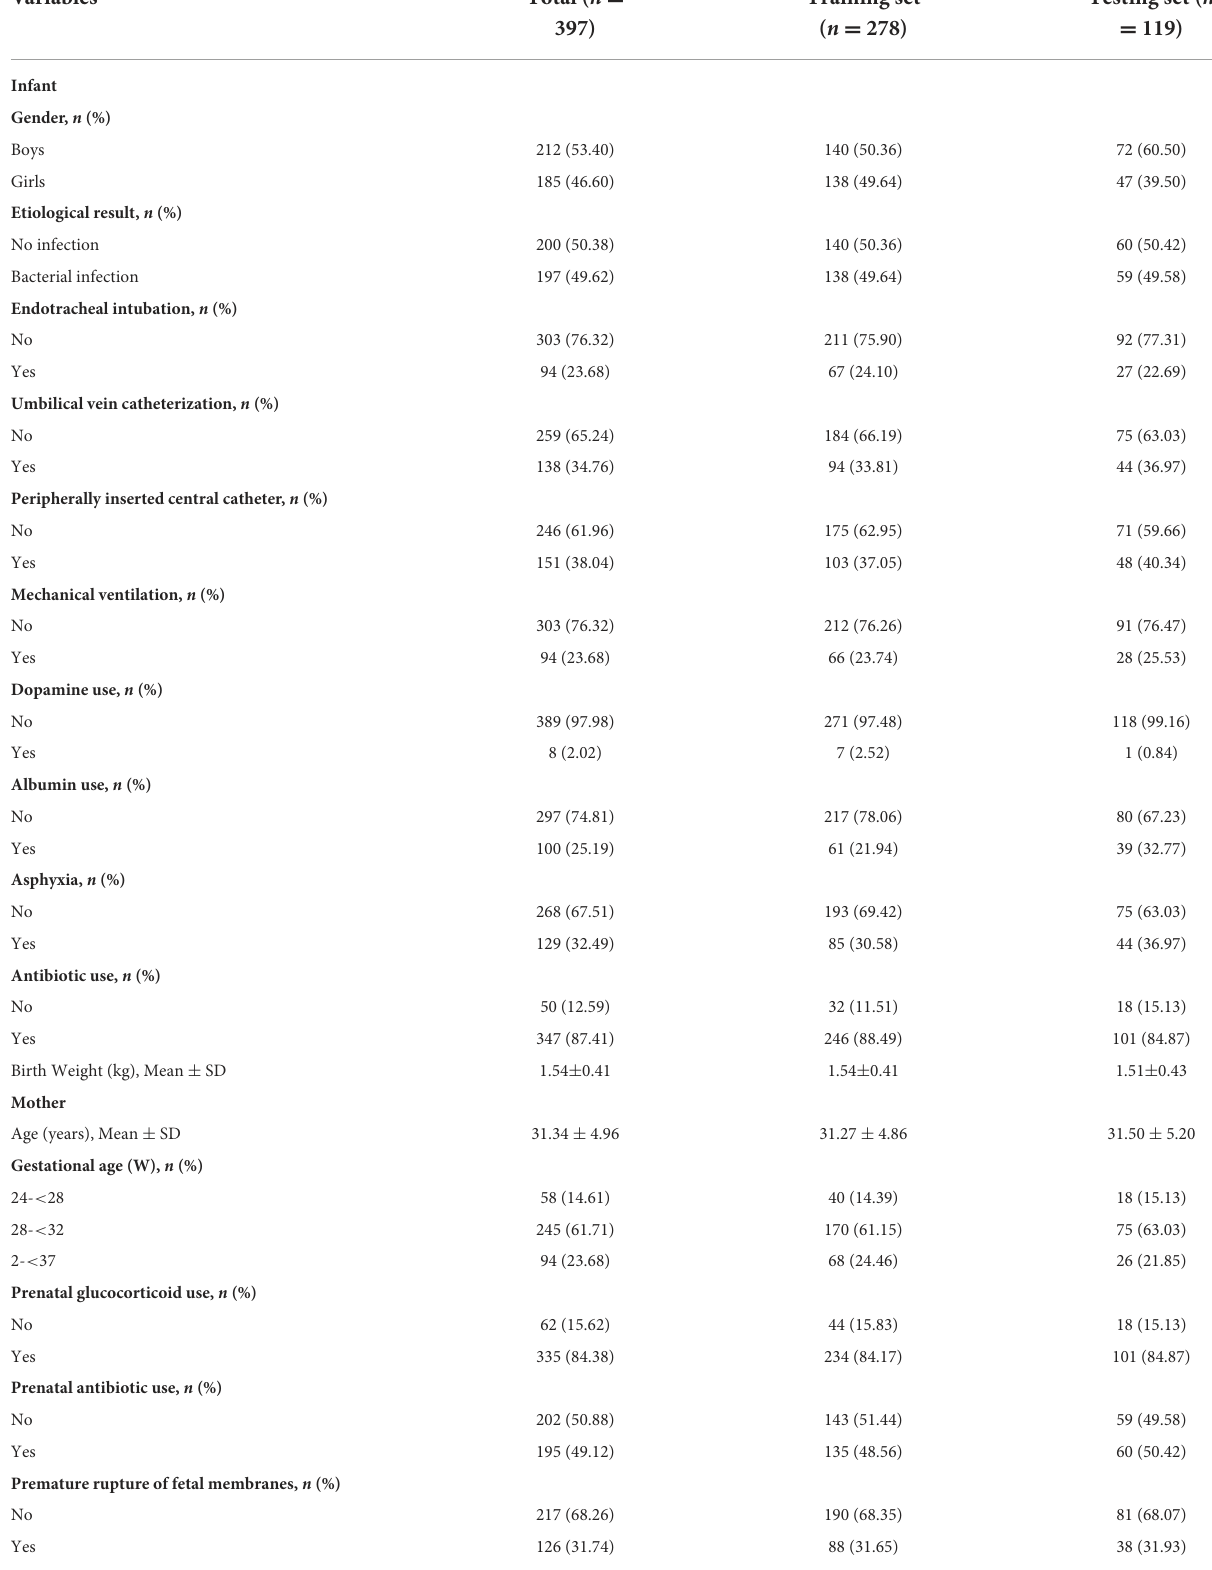
TABLE 1 The baseline characteristics of